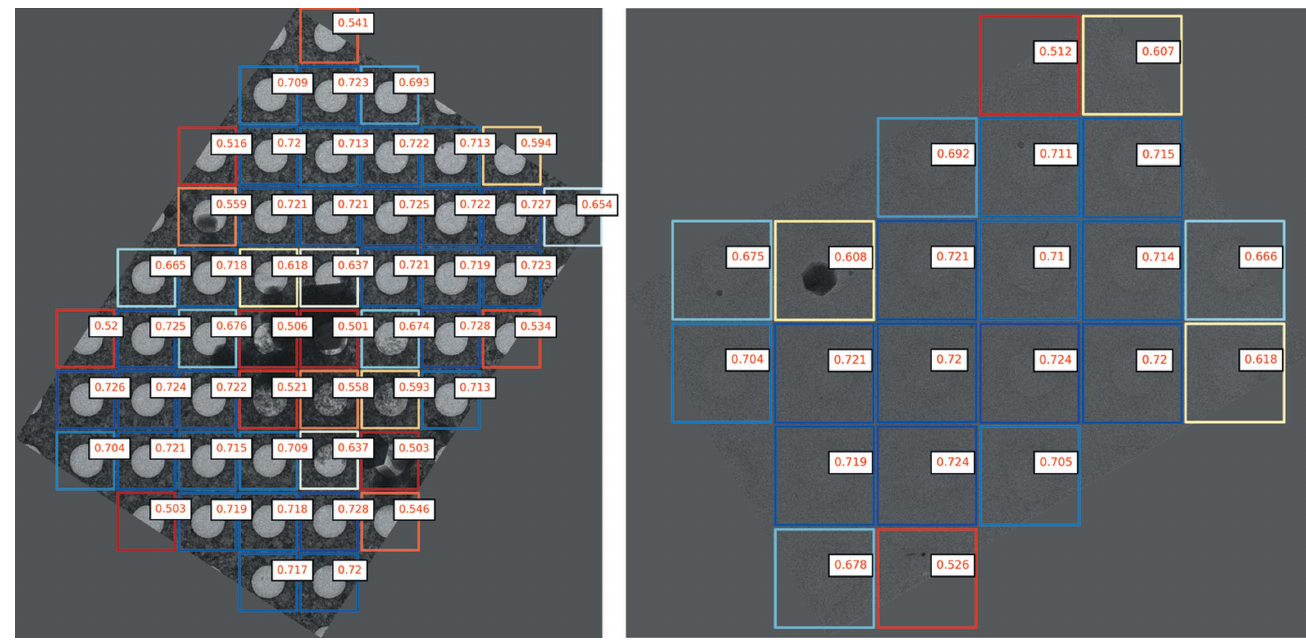
Figure 12 Example hole classifications in medium-magnification images using the average-pooling model. Ptolemy can successfully prioritize complete holes free of contaminants. Model-predicted probabilities for holes are in red. Colors from high to low score: dark blue, light blue, white, yellow, orange,